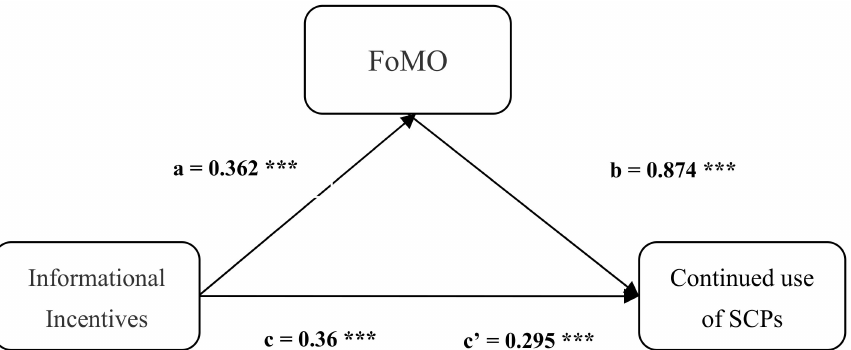
Figure 4. Mediation model. *** p < 0.001; n = 366; II indicates informational incentives; CUSCP indicates continued use of social commerce platform; FoMO indicates fear of missing out. Table 8. Path analysis of mediation model. Path Coefficient S.E. C.R. P II- > CUSCP 0.295 *** 0.038 8.064 0.000 II- > FoMO 0.362 *** 0.046 7.150 0.000 FoMO- > CUSCP 0.874 ** 0.063 9.632